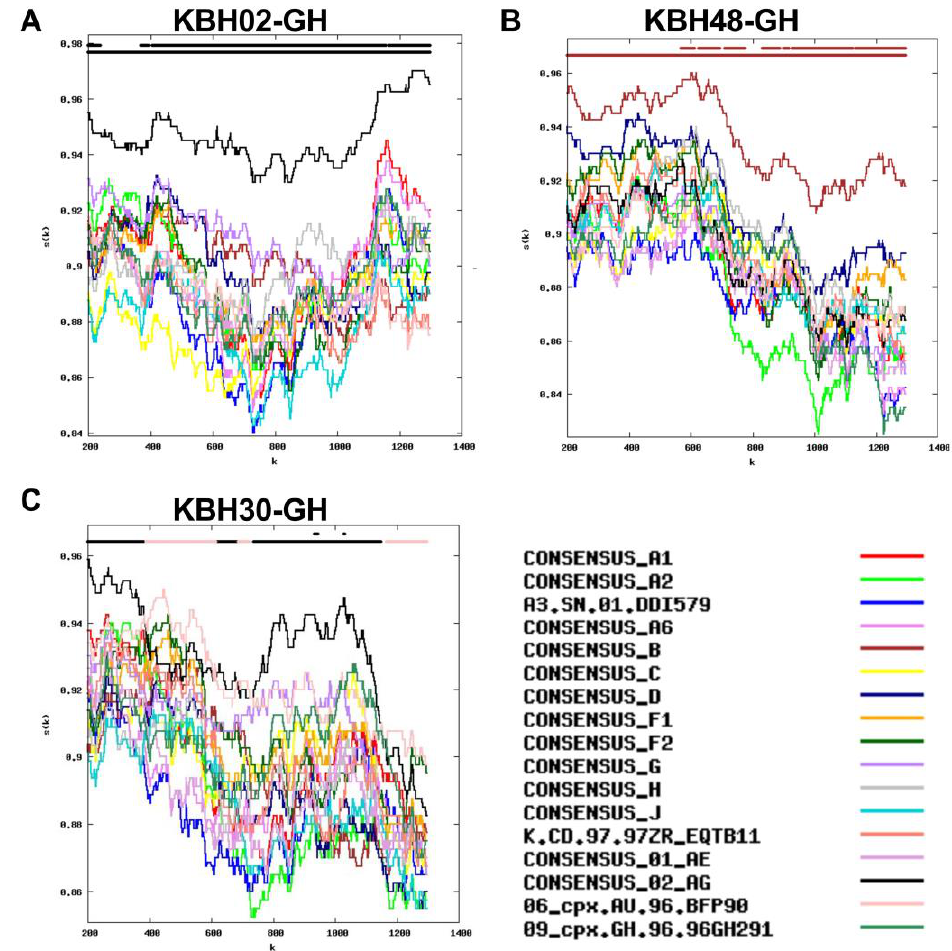
Figure 2. Subtype assignments based on protease-RT sequences. Panels ( A – C ): The y-axis denotes the % similarity between the participant sequence to each of 17 reference sequences (each in a different color) over a sliding window of 400 bases (shown on X axis). The bars at the top of each plot indicate the best matching reference sequence over a given sequence region (lower bar) and whether this match meets the 95% confidence threshold (upper bar). Panel ( A ) A “ pure ” CRF02_AG sequence in participant KBH02-GH. Panel ( B ) Pure subtype B in KBH48-GH. Panel ( C ) A sample that was classified as CRF02_AG based on two short CRF02_AG regions that met the 95% confidence threshold, but that is likely a recombinant of CRF02_AG and 06_cpx (participant KBH30-GH).